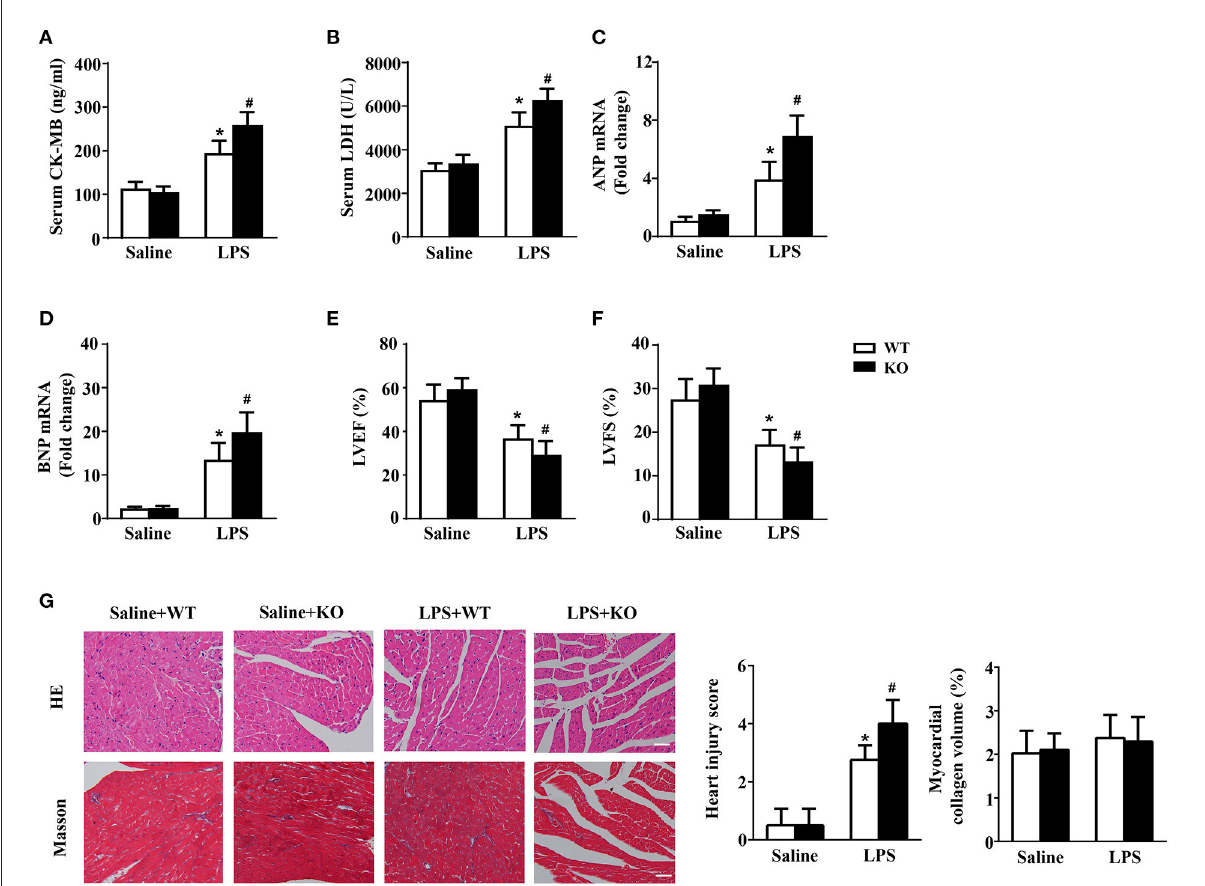
FIGURE2 IL-12p40 deletion aggravates LPS-induced cardiac injury and cardiac dysfunction in mice. (A,B) The levels of LDH and CK-MB in serum of mice in each group ( n = 6). (C,D) qRT-PCR analysis of ANP and BNP mRNA expression levels in the hearts of mice in each group ( n = 6). (E,F) Echocardiography analysis of LVEF and LVFS of mice in each group ( n = 6). (G) HE and masson’s trichrome stainings and the quantitative results of heart tissues in each group ( n = 6; scale bar, 100 µ m). * P < 0.05 compared with the Saline group. # P < 0.05 compared with the LPS + WT